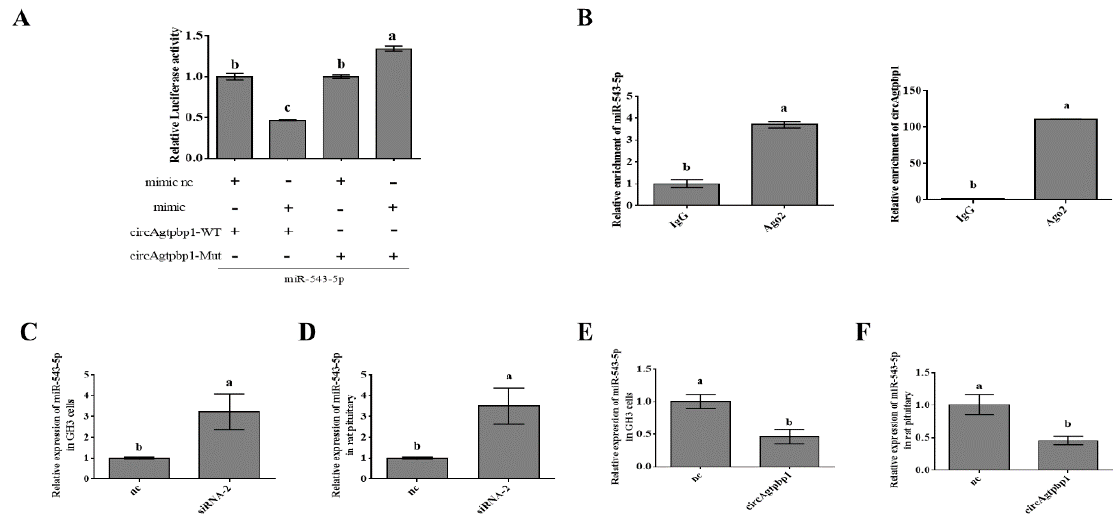
Figure 5. CircAgtpbp1 acts as a sponge for miR-543-5p in rat pituitary primary cells. ( A ) Luciferase assays were performed to detect the luciferase activities of 293 T cells to confirm the interaction between miR-543-5p and circAgtpbp1. ( B ) The Ago2 RIP assay showed that Ago2 significantly enriched miR-543-5p and circAgtpbp1 in rat pituitary cells. ( C ) MiR-543-5p expression increased upon circAgtpbp1 knockdown by siRNA-2 in GH3 cells. ( D ) MiR-543-5p expression increased upon circAgtpbp1 knockdown by siRNA-2 in rat pituitary cells. ( E ) MiR-543-5p expression decreased after circAgtpbp1 overexpression in GH3 cells ( F ) MiR-543-5p expression decreased after circAgtpbp1 overexpression in rat pituitary cells. At least three replicates of each experiment were performed. Mean values and standard deviations (SD) of data are shown. One-way ANOVA and independent-samples t-test were applied to determine statistical significance. p < 0.05 was considered significant. Different letters (a,b) indicate significant differences between groups ( p < 0.05). *, p < 0.05.